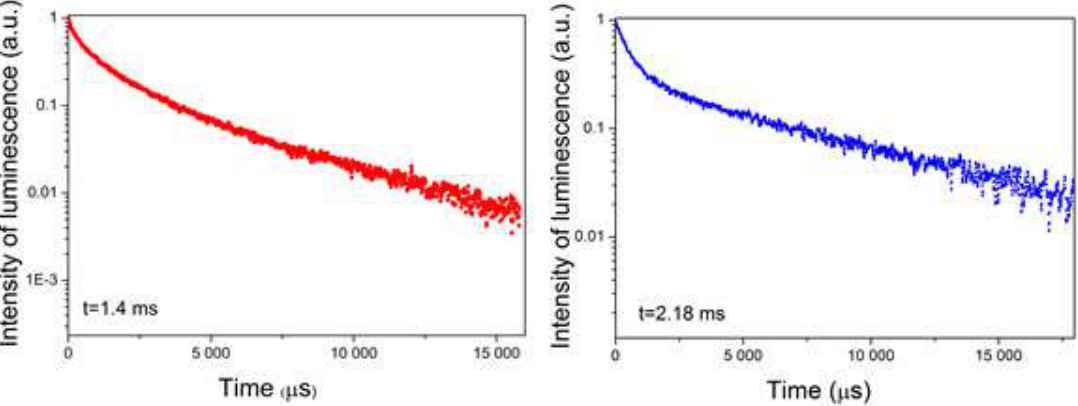
Figure 12. Luminescence decay curves for willemite sample W1 measured at T = 300 K and T = 77 K (red and blue line, respectively).